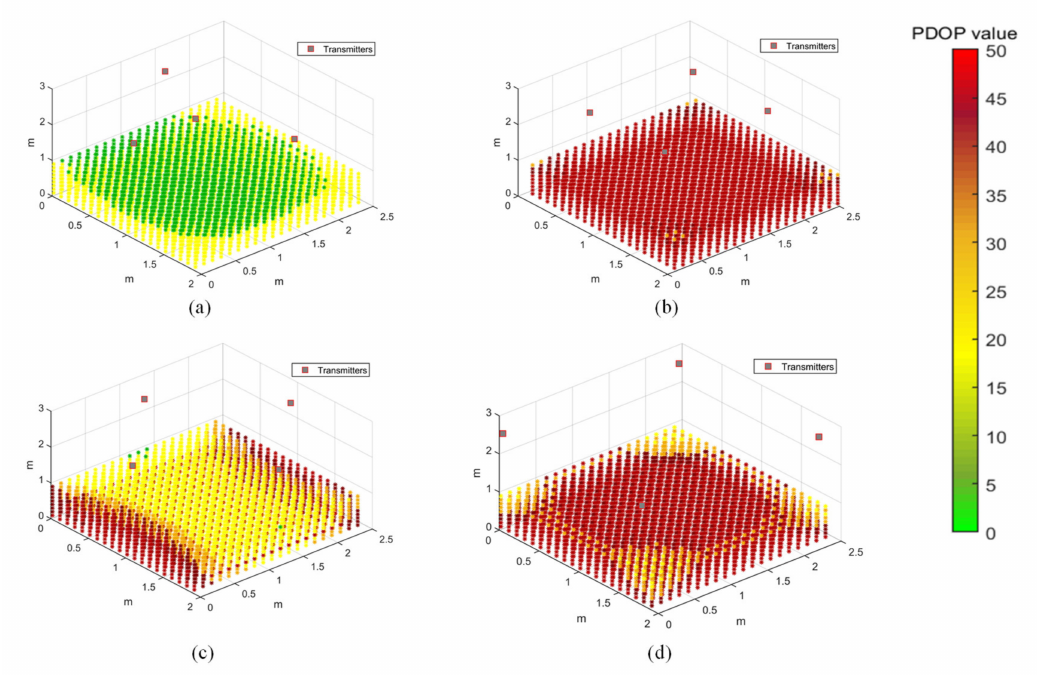
Figure 8. Position dilution of precision (PDOP) distribution for di ff erent transmitter arrangements. ( a ) Transmitters arranged in a triangle, with one transmitter at its median. ( b ) Transmitters arranged along a rectangle within the test area. ( c ) Transmitters arranged at the centre of the edges of the test area. ( d ) Transmitters arranged at the corners of the test area.